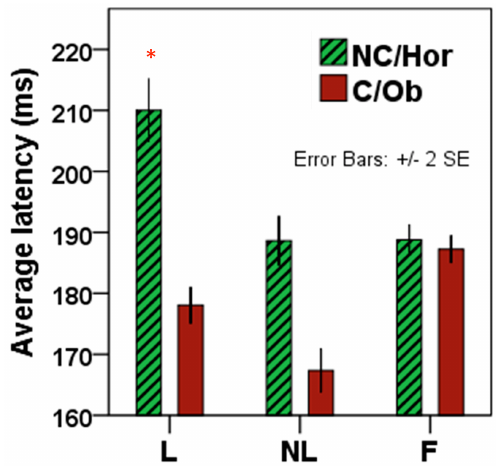
Figure 6 . Mean saccadic latencies per condition (Launch- ing/No-Launching/Fixation) and target selection (color coded: red bars indicate that the first saccade after colli- sion was closer to the causal/oblique target. Green, dashed bar plots indicate saccades to the non- causal/horizontal target). Plotted are group means/SDs for the first saccade after